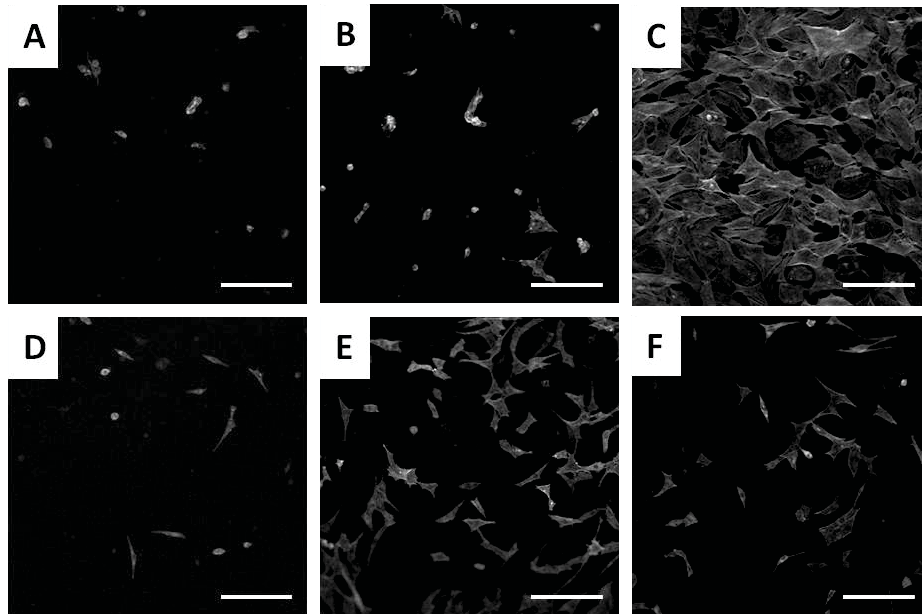
Figure 5. Confocal laser scanning images of C3H10T1/2 cells on Ca 2+ - and Fe 3+ -crosslinked NFC hydrogels: ( A ) unmodified Ca 2+ -NFC hydrogel; ( B ) Ca 2+ -NFC hydrogel with physically adsorbed PF; ( C ) Ca 2+ -NFC hydrogel covalently attached PF; ( D ) unmodified Fe 3+ -NFC hydrogel; ( E ) Fe 3+ -NFC hydrogel with physically adsorbed PF; ( F ) Fe 3+ -NFC hydrogel with covalently attached PF. (Scale bar denotes 200 µ m). Reprinted with permission from the authors of [117]. Copyright 2014 American Chemical Society.